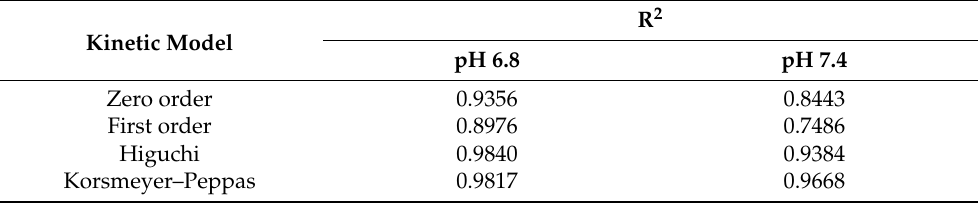
Table 6. Kinetic models used in the evaluation of the RIF release mechanism from the Mt–RIF nanohybrid. Kinetic